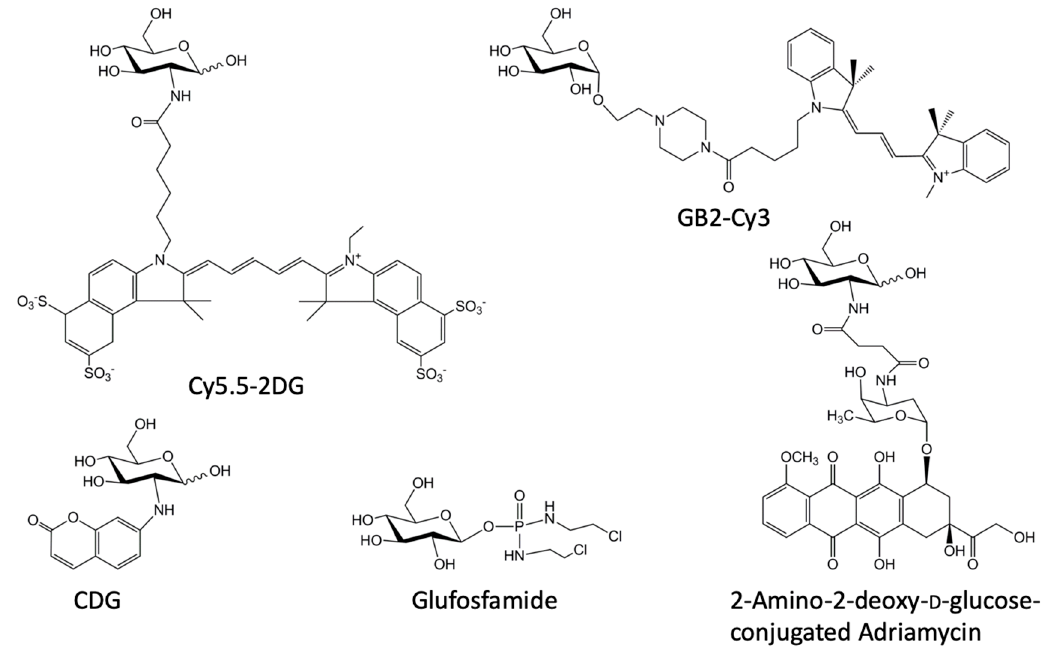
Figure 4. Structures of various D -glucose analogues.